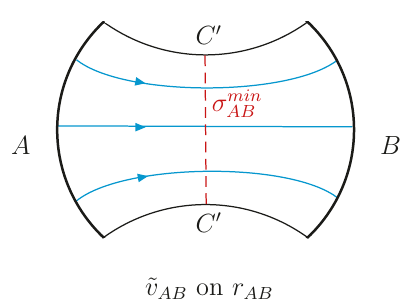
Figure 4 . A sketch of a vector (cid:12)eld v AB on r AB , which is de(cid:12)ned as a (cid:13)ow from A to B, whose (cid:13)ux is bounded above by the area of the neck (cid:27) min . There is a max (cid:13)ow ~ v AB among all allowed AB (cid:13)ows v AB . Meanwhile, the (cid:13)ux achieves its maximum value E P ( A : B